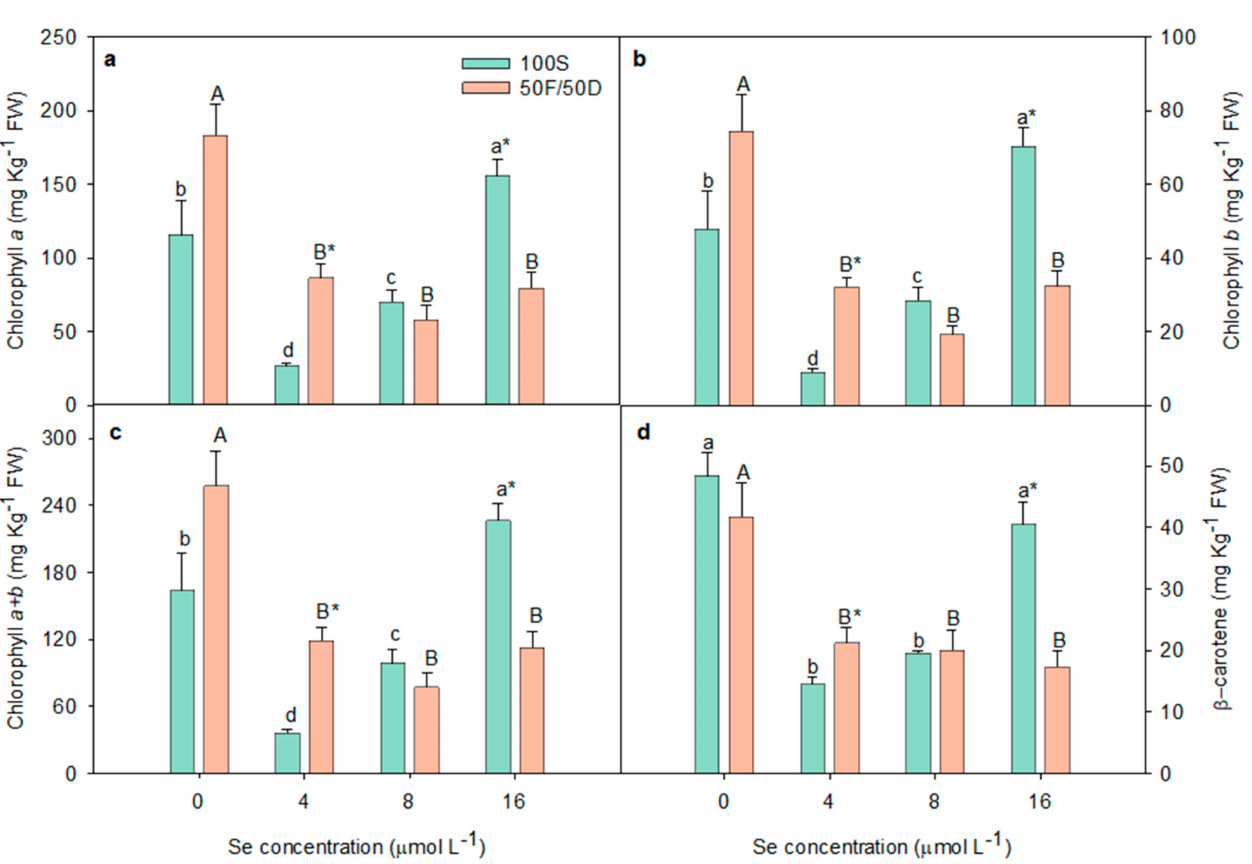
Figure 2. Effects of different selenium concentration (0, 4, 8, and 16 µ moles L − 1 ) and two types of irrigation water (100S or 50F/50D) on: ( a ) chlorophyll a ; ( b ) chlorophyll b ; ( c ) chlorophyll a + b ; and ( d ) β -carotene in lettuce. The data are presented as the treatment means ( n = 6). Different lower-case letters indicate significant ( p ≤ 0.05) differences between different dosages of selenium combined with the 100S treatment and different capital letters indicate significant ( p ≤ 0.05) differences between different dosages of selenium combined with the 50F/50D treatment. * denotes significant differences ( p ≤ 0.05) between plants submitted to 100S treatment and those irrigated with 50F/50D for the same Se